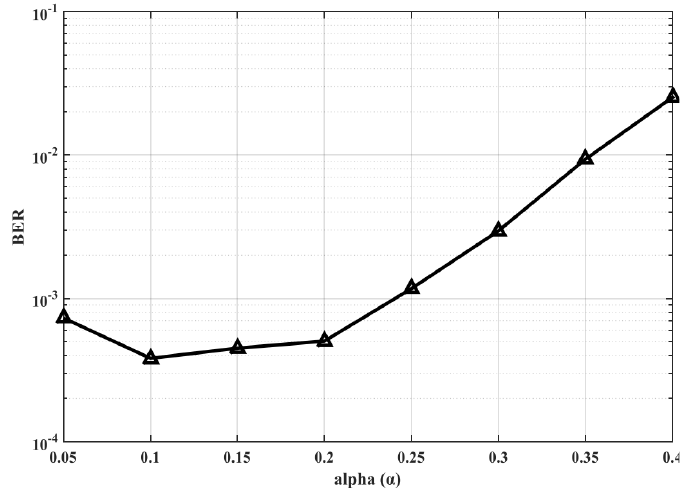
Figure 3. Bit error rate (BER) performance of proposed signal detection scheme based on scaling factor α .